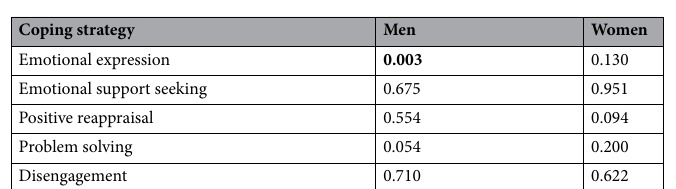
Figure 1. The adjusted mean eGFR values for each level of perceived stress, problem solving, and positive reappraisal according to gender. Symbols show averages and error bars represent the 95% confidence intervals. Adjustments were made for age, area, lifestyle factors (drinking, smoking, physical activity, sleeping hours, energy intake, and body mass index), and psychosocial factors (perceived stress and all coping strategies). β represents the regression coefficient of each psychosocial factor as an ordinal variable and P for trend denotes the statistical significance of β (see Model 3 in Table 3 for details).